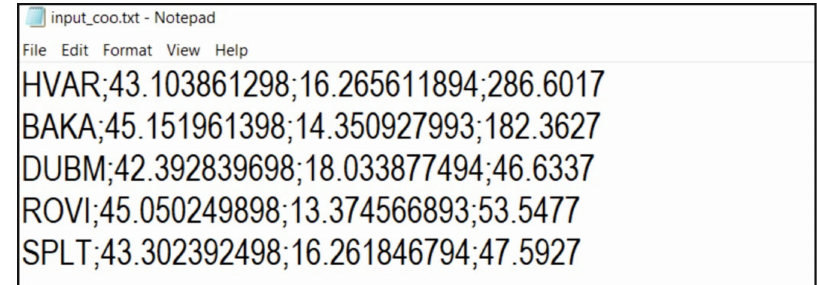
Figure 3. Set of ellipsoidal degrees, minutes, and seconds (DMS) coordinates: ellipsoidal latitude ( ϕ ), ellipsoidal longitude ( λ ), and ellipsoidal height h ( m